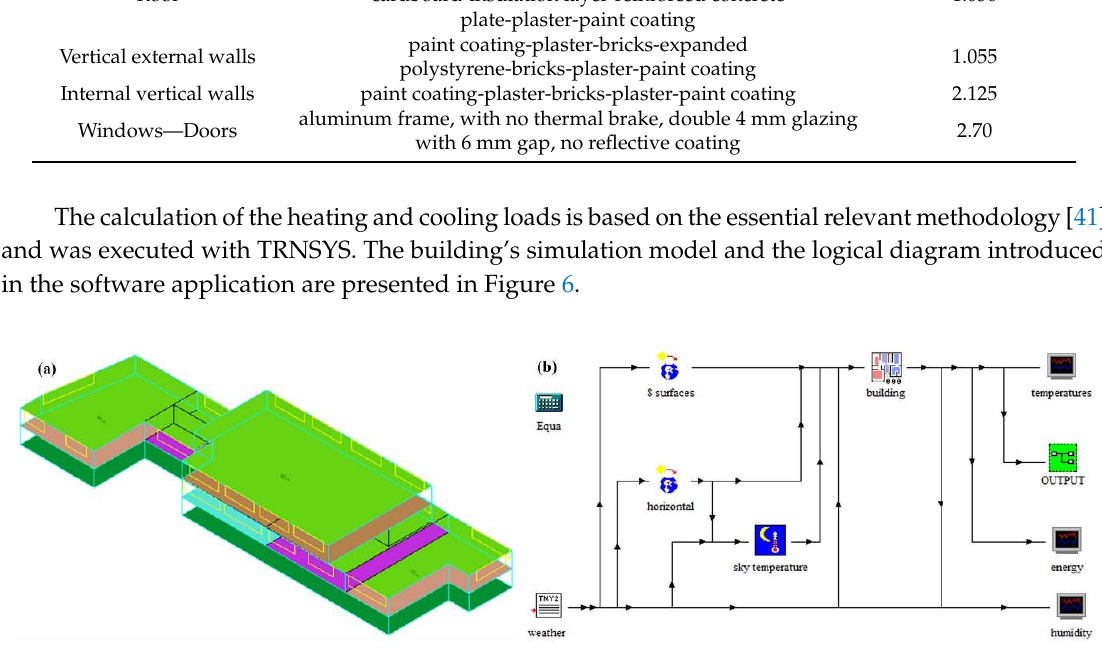
Figure 6. Building’s computational simulation model ( a ) and calculation logical diagram ( b ) introduced in TRNSYS for the heating and cooling loads calculation.